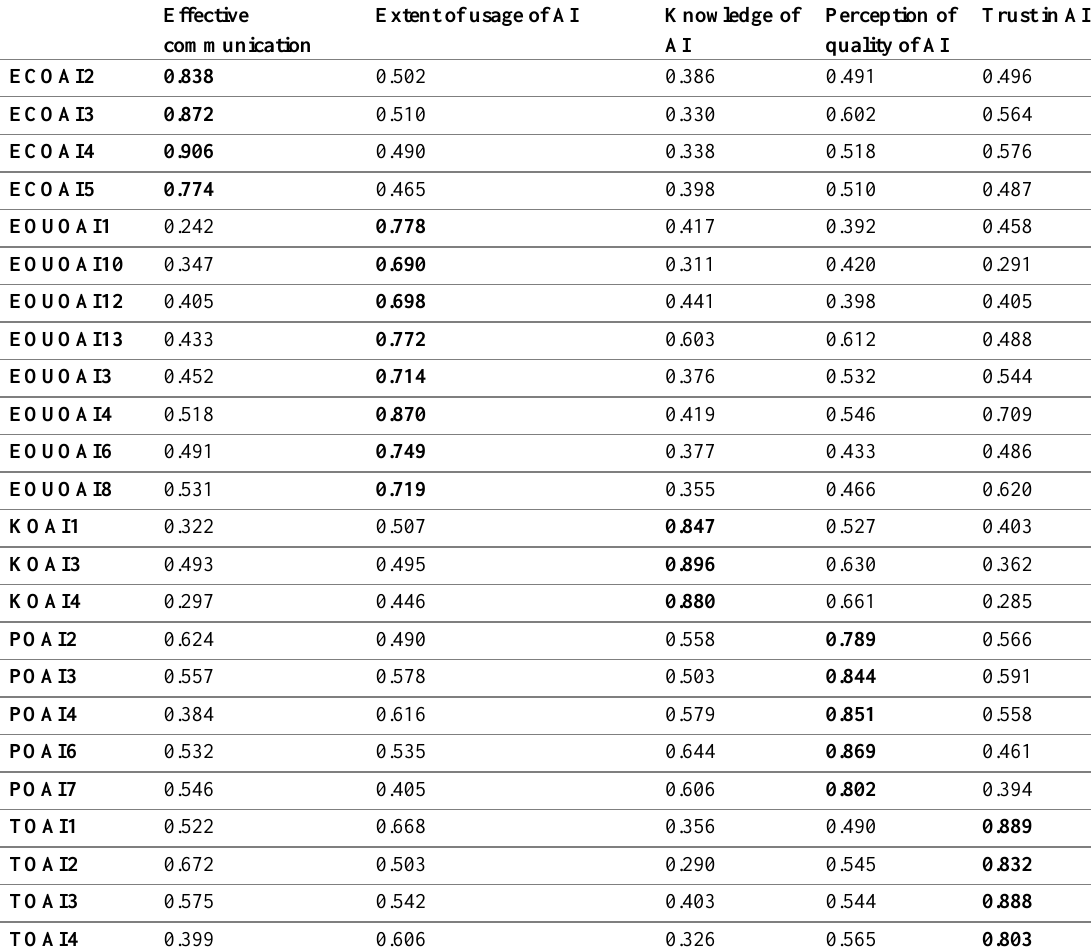
Table 5: Cross- Loadings